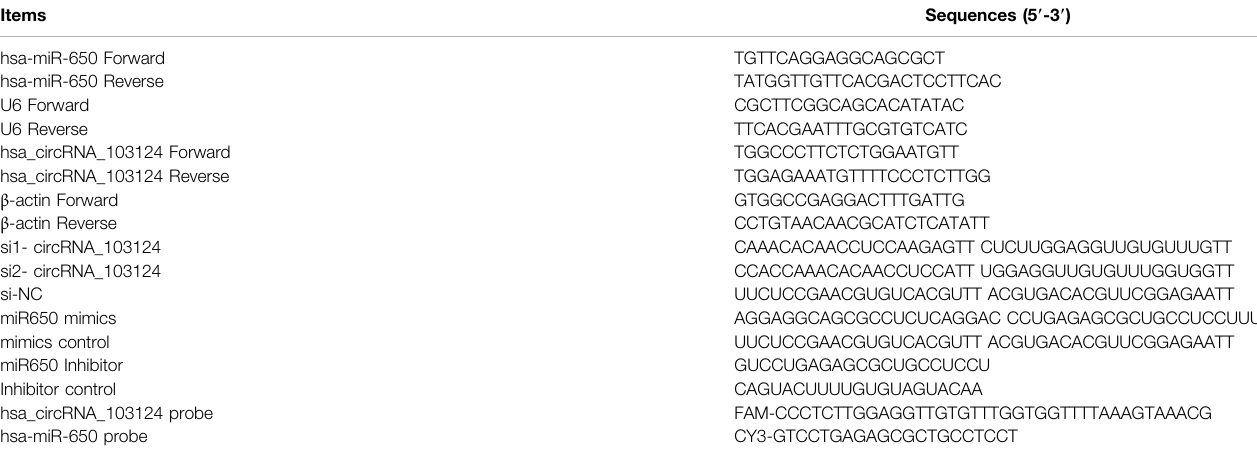
TABLE 2 | Sequences of primers, siRNAs, microRNA inhibitor, microRNA mimics, and speci fi c probes.